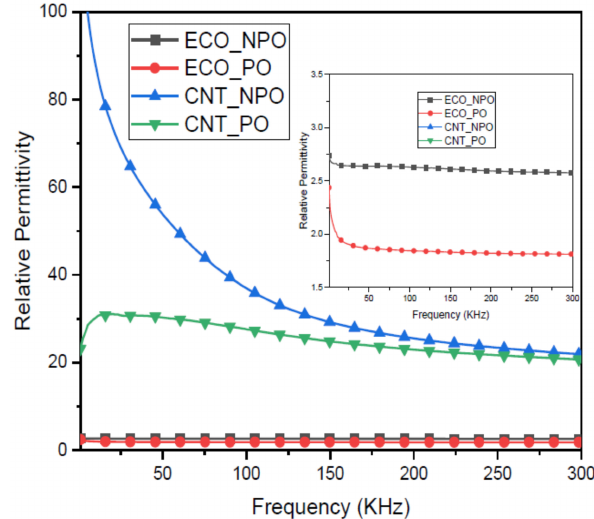
Figure 12. Frequency dispersion of relative permittivity of dielectric layers.